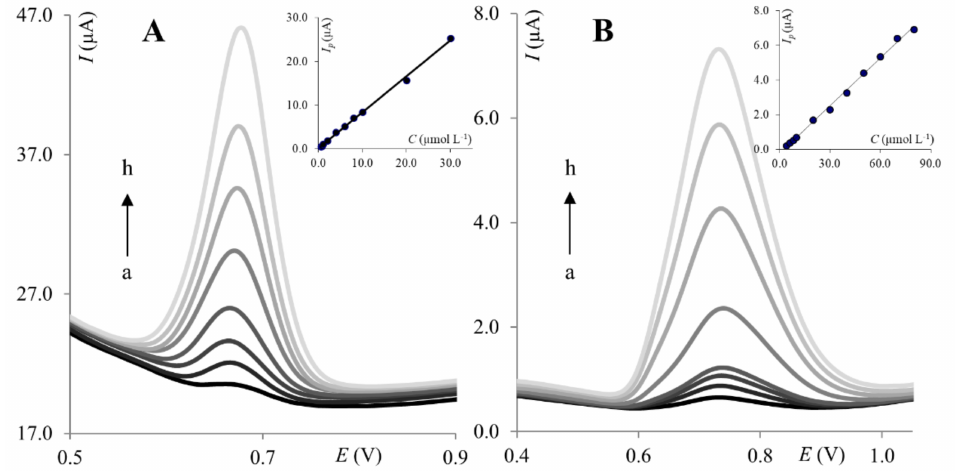
Figure 5. Voltammograms of PA recorded on the ClPE ( A ) and GrPE ( B ). ( A ): (a) 6.0 × 10 − 7 mol L − 1 , (b) 1.0 × 10 − 6 mol L − 1 , (c) 2.0 × 10 − 6 mol L − 1 , (d) 4.0 × 10 − 6 mol L − 1 , (e) 8.0 × 10 − 6 mol L − 1